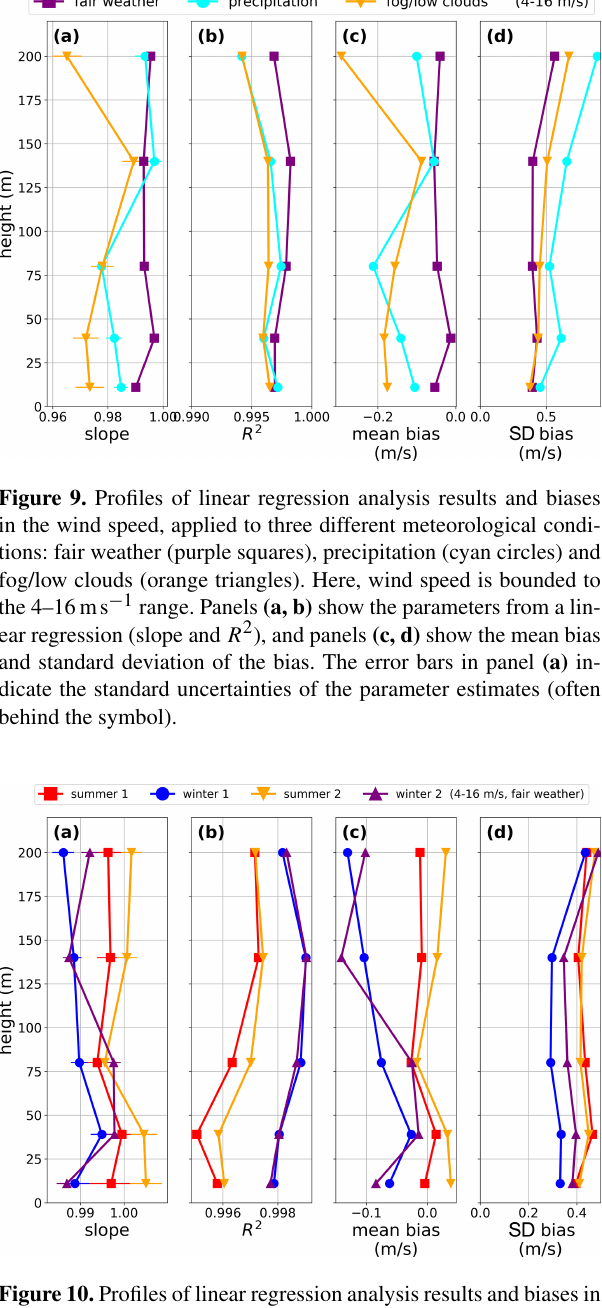
Figure 10. Profiles of linear regression analysis results and biases in the wind speed, applied to the two summers (June, July and August) and winters (December, January and February). Here, wind speed is bounded to the 4–16ms − 1 range and only fair weather conditions are taken. Panels (a, b) show the parameters from a linear regression (slope and R 2 ), and panels (c, d) show the mean bias and standard deviation of the bias. The error bars in panel (a) indicate the stan- dard uncertainties of the parameter